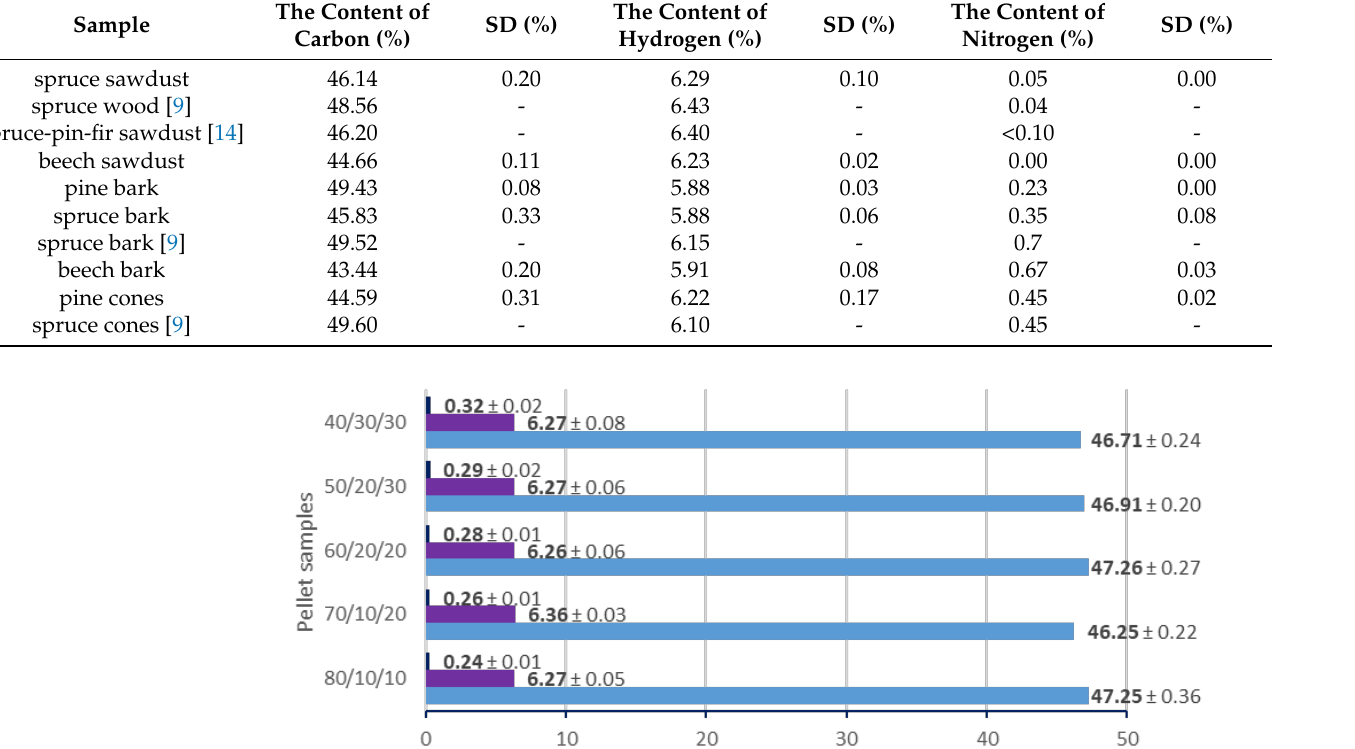
The results from the elemental analysis of individual produced pellets are shown in Figure 3. The measured results for carbon content are in the range of 46.25 – 47.26%; hy-